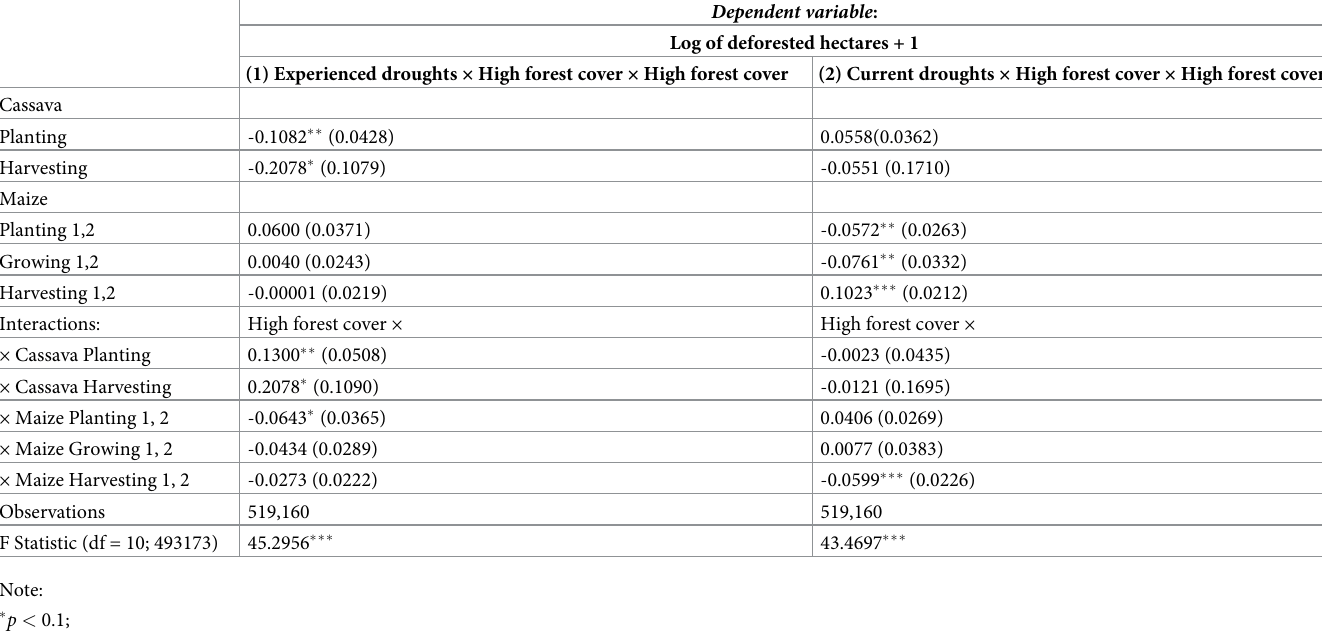
Table 4. Deforestation and droughts over the main agricultural periods and cycles, interaction with high baseline forest cover. Total observations are then sampled to maintain only the 35% of the total